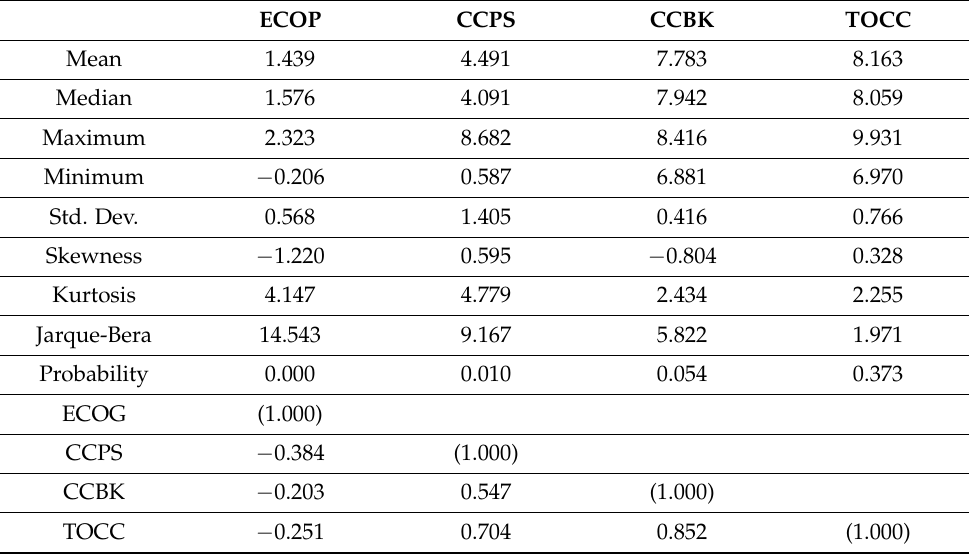
Table 1. Outcomes of exploratory data analyses and